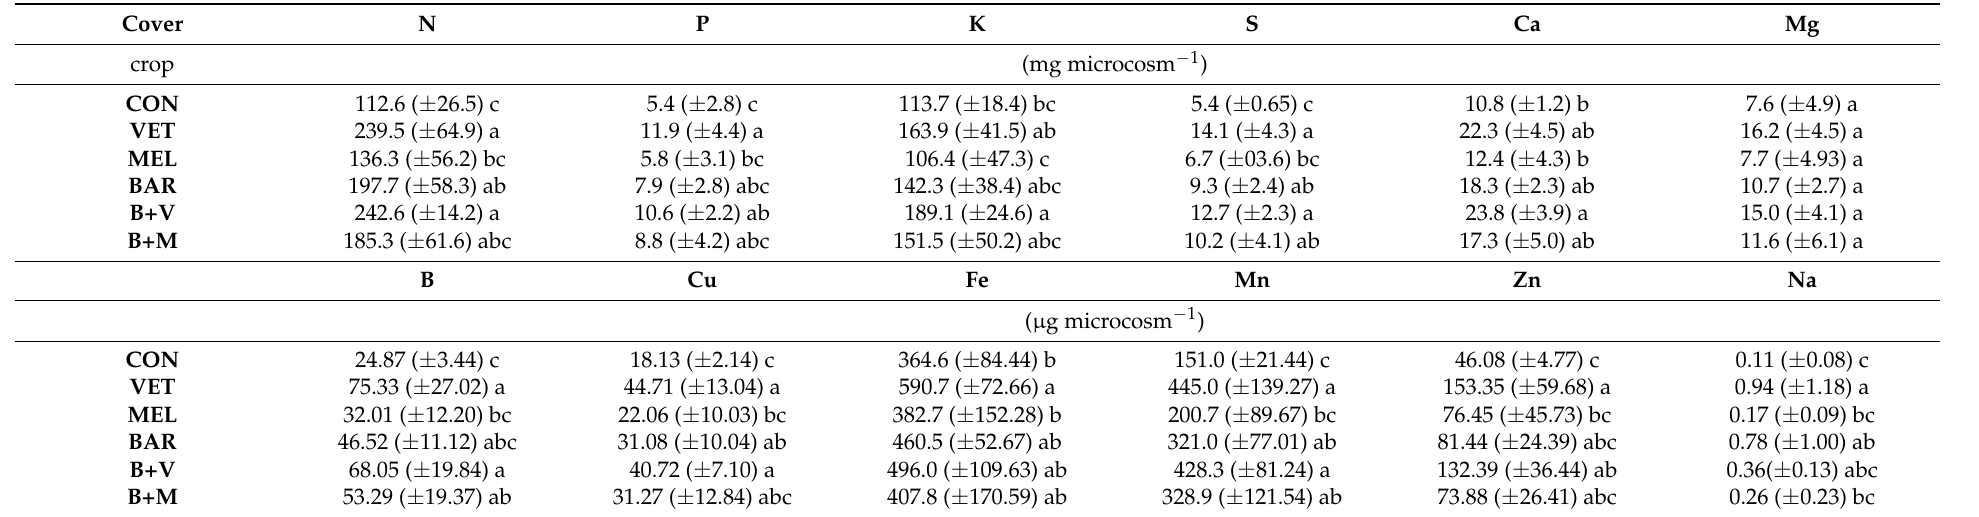
Table 3. Macro and micronutrient contents in wheat shoots after the different cover